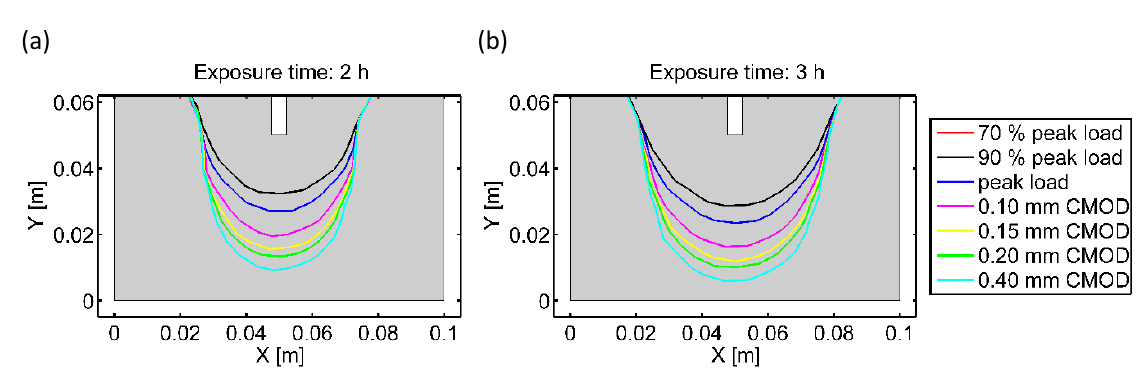
Figure 4. Numerical predictions of extend of moisture ingress for loaded/cracked WST specimens at selected times after exposure to liquid water. Estimated crack lengths can be deduced from Fig. 3a as the distance from notch to where COD=0. After [31].